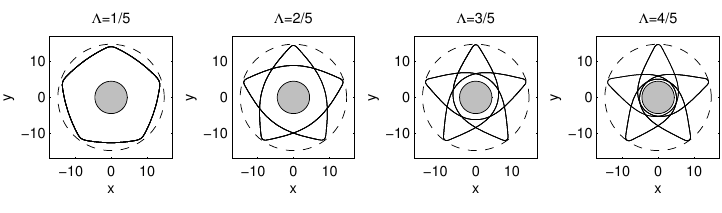
Figure 3. A family of periodic orbits with L found from Λ = 1/5, 2/5, 3/5 and 4/5. The orbits reflect off of the plasma shell 5 times, and the orbital path intersects itself 0, 5, 10 and 15 times, respectively. The CO is the shaded disc, and the unstable circular orbit is marked with a dashed line.